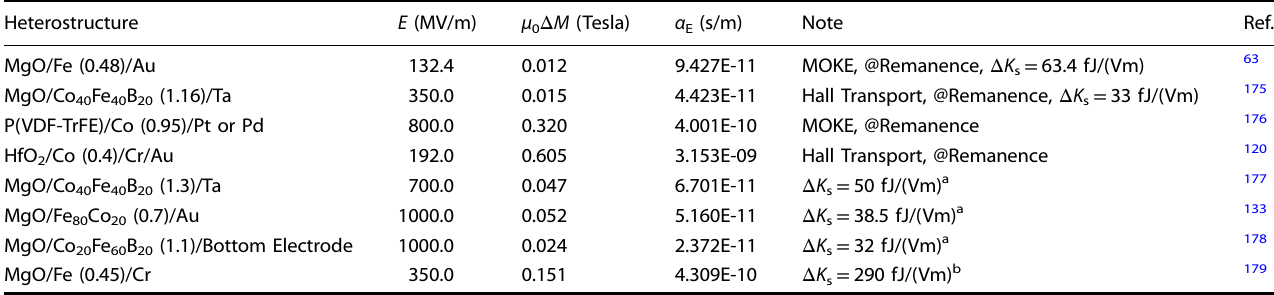
Table 3a. Some experimental reports of converse magnetoelectric coupling in horizontal magnetoelectric heterostructures, mediated by electrically driven change of interfacial charge densities Heterostructure Note Ref. MgO/Fe (0.48)/Au